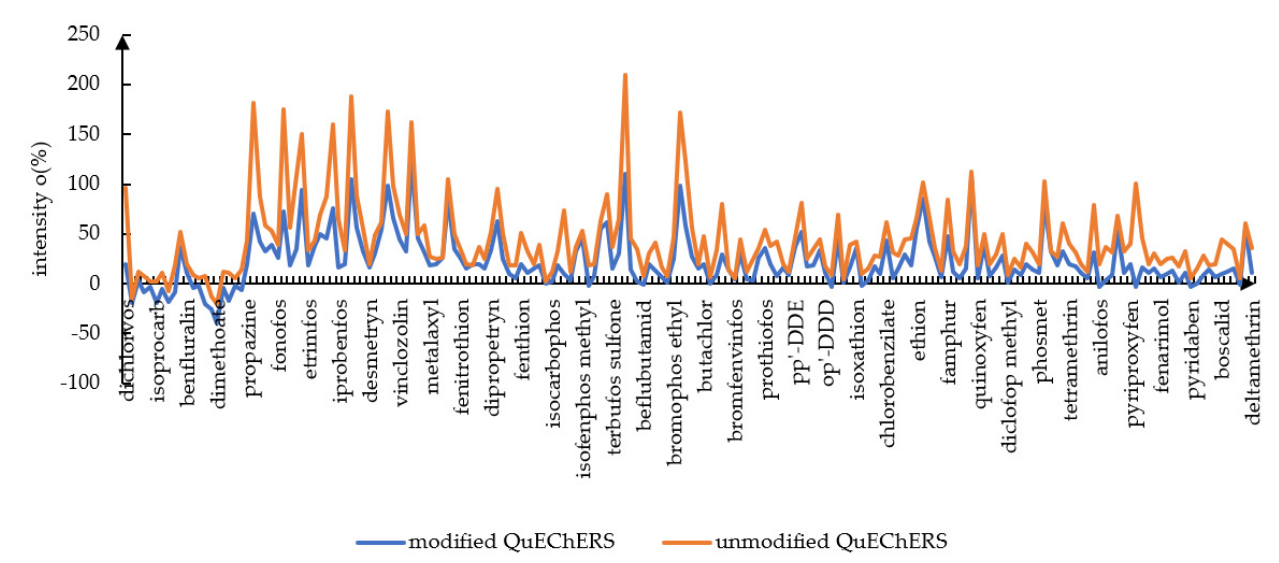
Figure 2. The comparison of matrix effect by modified QuEChERS and unmodified